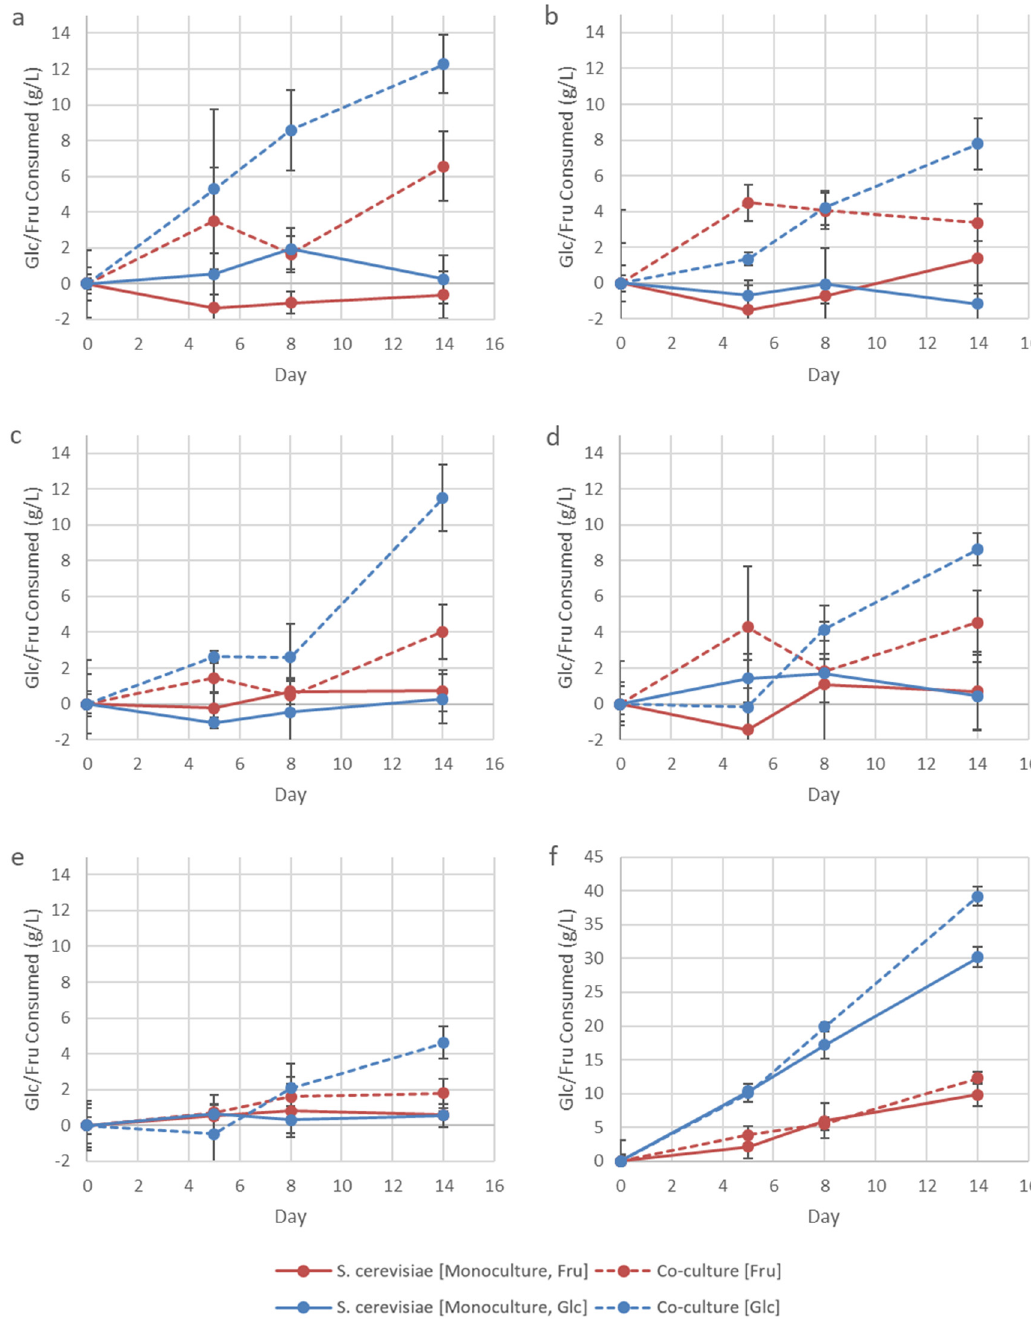
Figure 3. Total glucose (Glc) and fructose (Fru) consumed over the 14-day incubation period by S. cerevisiae mono- and co-cultures for the Lys-Ile ( a ), Lys-Ala ( b ), Lys-Val ( c ), Lys-Met ( d ), Lys-Ile-Ala-Val-Met ( e ), and control ( f ) treatments. Data shown are means of triplicates, with error bars representing standard deviation.